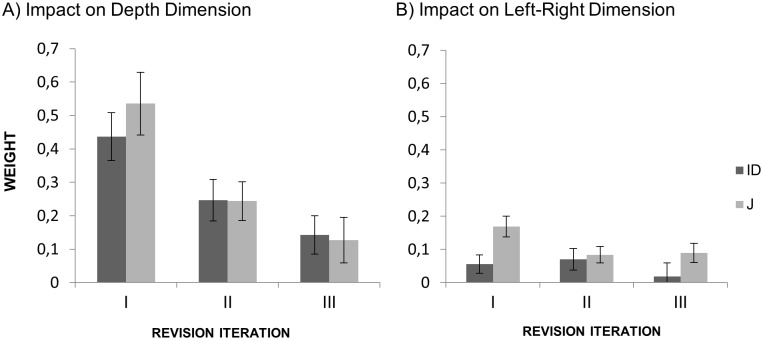
Impact of judgments from another viewpoint in Experiment 1.(A) Impact on front-back dimension. (B) Impact on left-right dimension. Error bars stand for within-subject 95% CI.